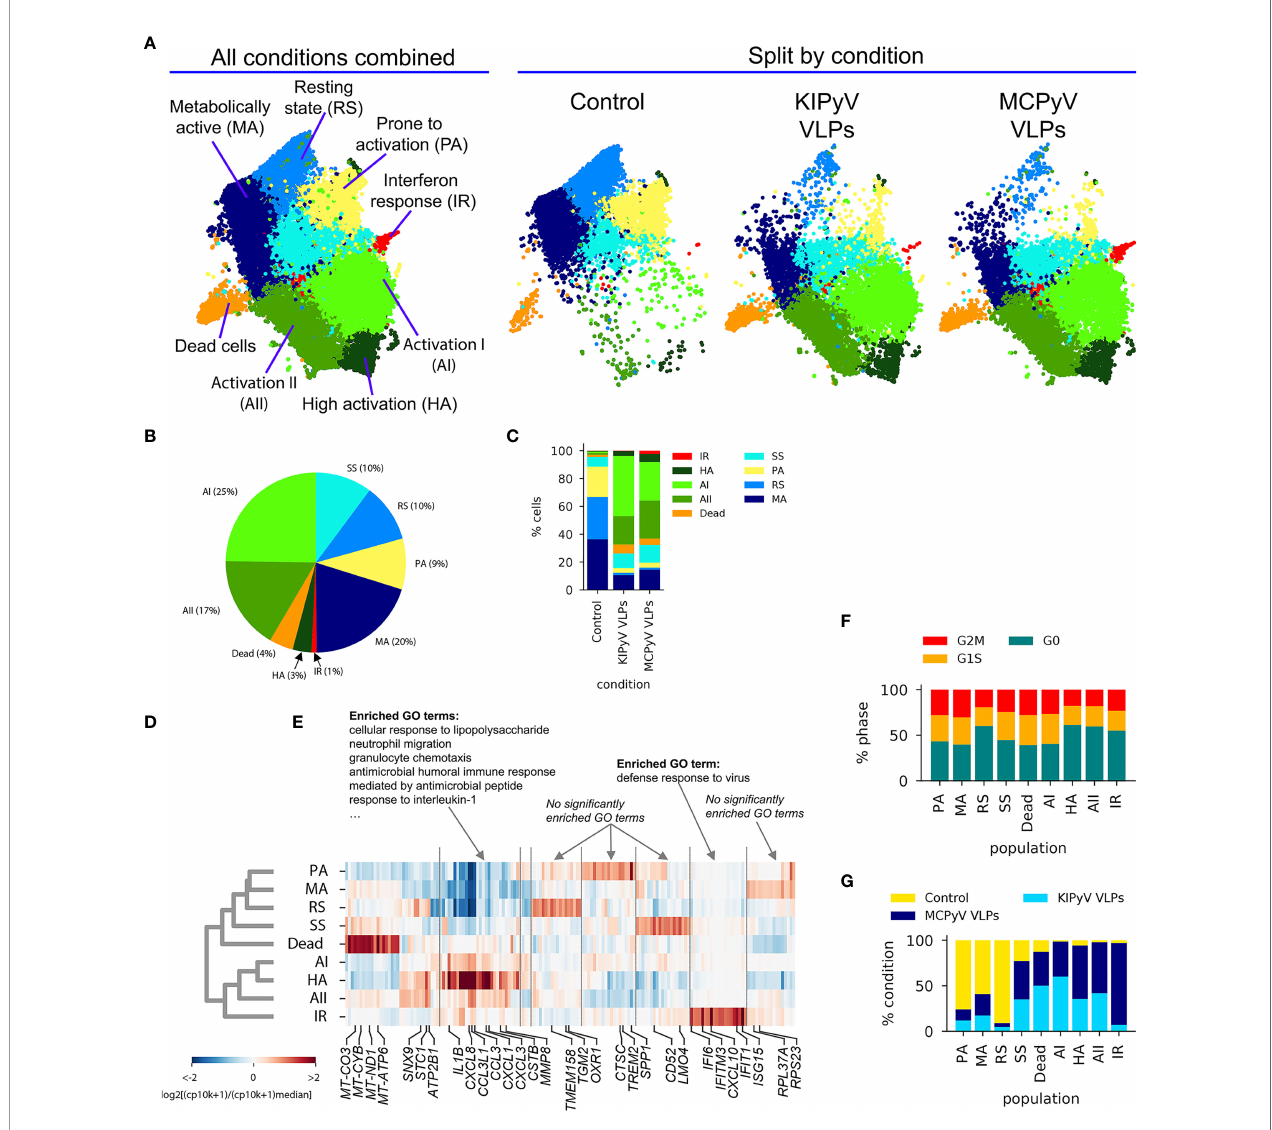
FIGURE 9 | ScRNAseq revealed different cell populations within THP-1 macrophages treated with PyV-derived VLPs. (A) UMAP colored by cell population annotation either combining all conditions (left) or split by condition (right). Percentages of cells per population for all data combined (B) or split by condition (C) . Results of population-enriched gene identi fi cation, including a population dendrogram (D) based on hierarchical clustering (correlation distance measure, average linkage) by enriched gene expression (E) . Selected genes are highlighted at the bottom. Results of GO enrichment analysis on selected genes groups are shown on top. CP10K — counts per 10,000. (F) Relative abundances of each population by condition. As this analysis is sensitive to the total number of cells sampled by condition, cell counts from each condition were fi rst normalized to 10,000. (G) Relative abundance of cells at different cell cycle stages de fi ned based on gene expression